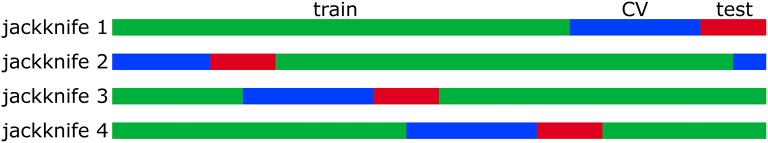
The data samples for each neuron are divided into 70% training (green), 20% cross-validation (blue), and 10% test (red) sets. The samples that appear in each set are varied between 4 jackknives.